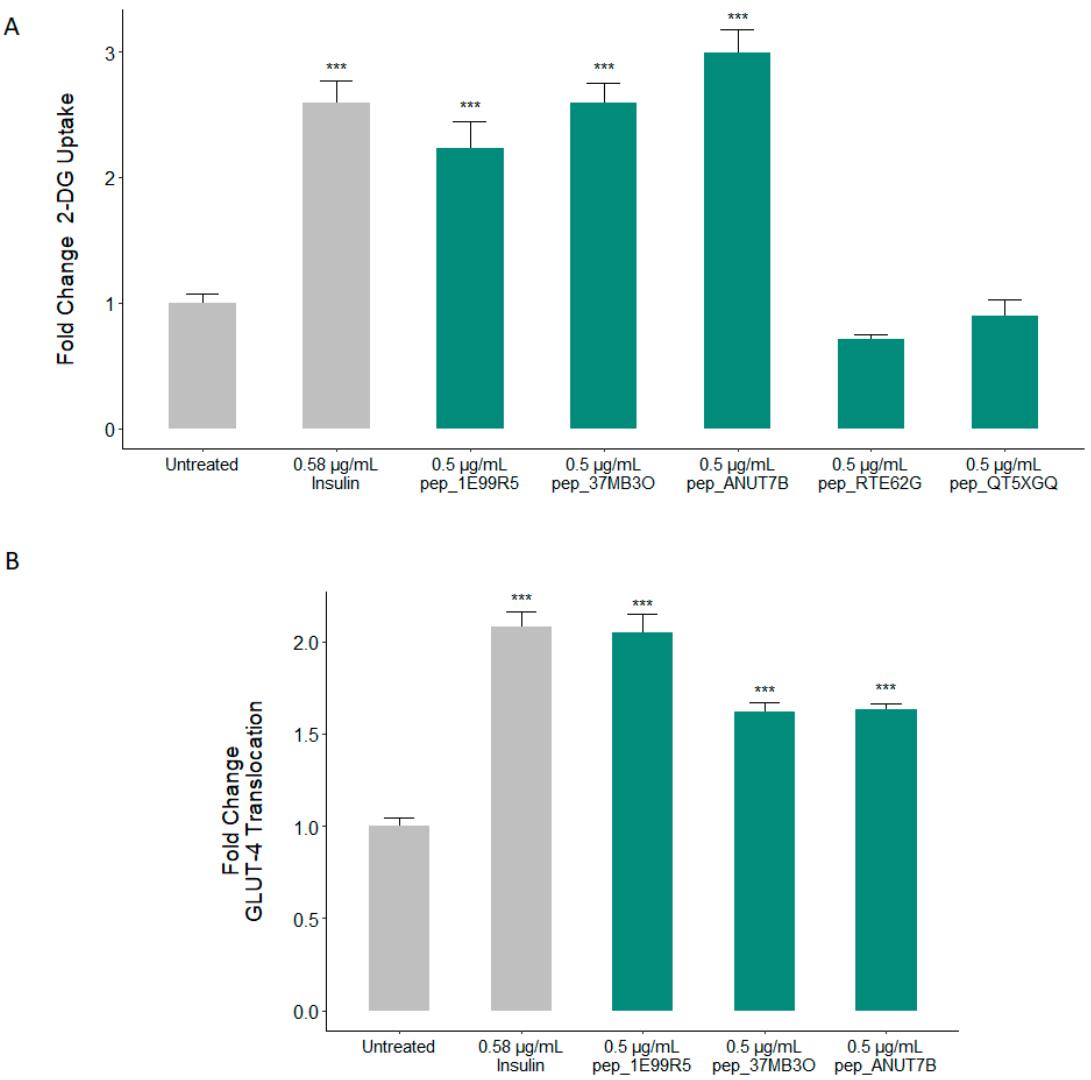
Figure 2. In vitro validation of predicted peptides as potent stimulators of glucose uptake and Glucose transporter type 4 (GLUT4) translocation. Skeletal muscle cells were stimulated with either insulin or predicted natural peptides at the indicated concentrations for 15 min. ( A ) The effect on glucose uptake is measured, while in ( B ), the extent of GLUT4 translocation is assessed (one-way ANOVA analysis with Dunnett’s test; *** p < 0.001; data presented are the mean ± SEM of at least 3 independent replicates).